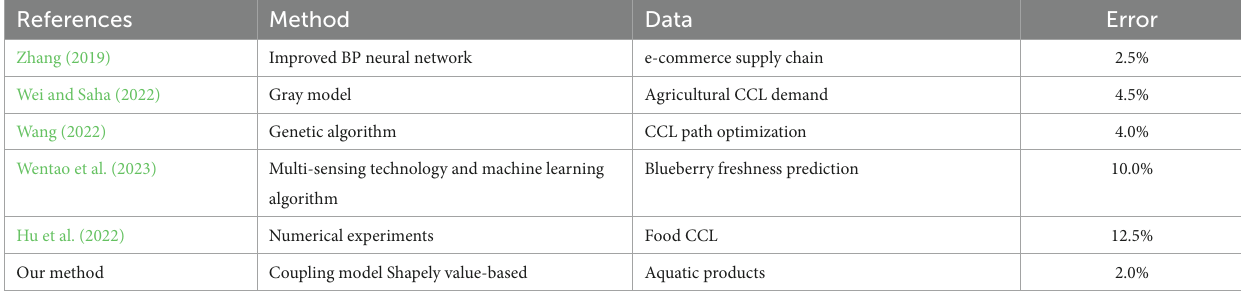
TABLE 9 Comparative analysis between our method and others in CCL